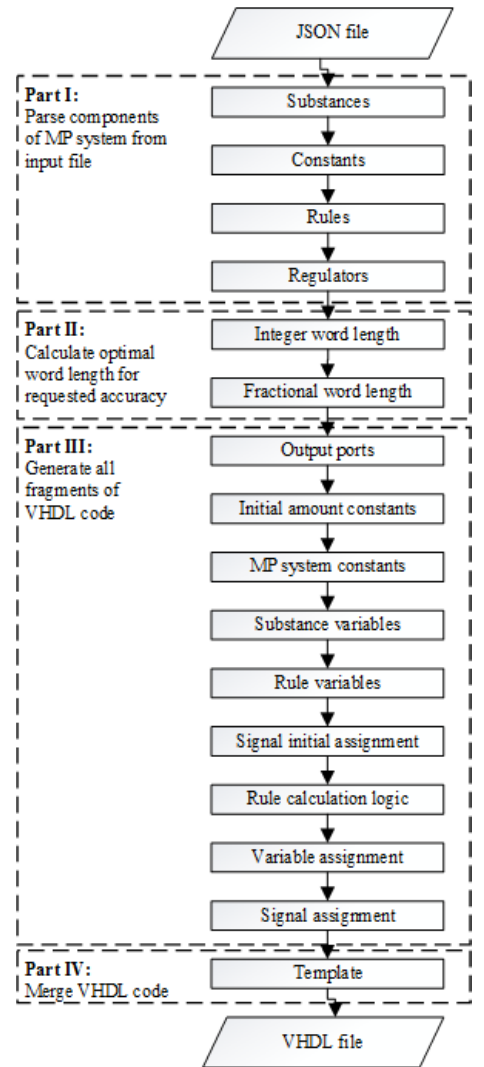
Fig. 1. MP system VHDL code generation tool. Fig. 2. Pseudocode of algorithm to find the optimal word